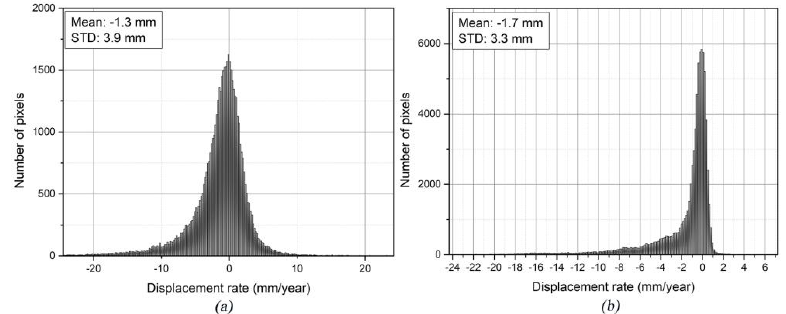
Figure 7. Histogram distribution for the PALSAR-derived results from June 2006 to December 2010. ( a ) The corresponding histogram of the PSI measurements from the PALSAR data; and ( b ) the corresponding histogram of the SBAS measurements from the PALSAR data.